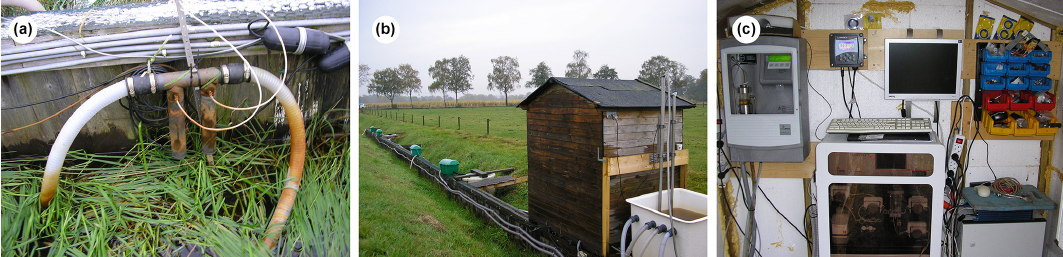
Figure 3. Pictures of the controlled drainage period setup: (a) the drainage overflow levels were adjusted by attaching the flexible connection tube (with a SorbiCell socket between the black fasteners) at the desired level; (b) the tube drain effluent was pumped to a collection vessel to enable continuous monitoring of NO 3 –N and total-P concentrations using a Nitratax-UV sensor and a Phosphax auto-analyzer (c) .